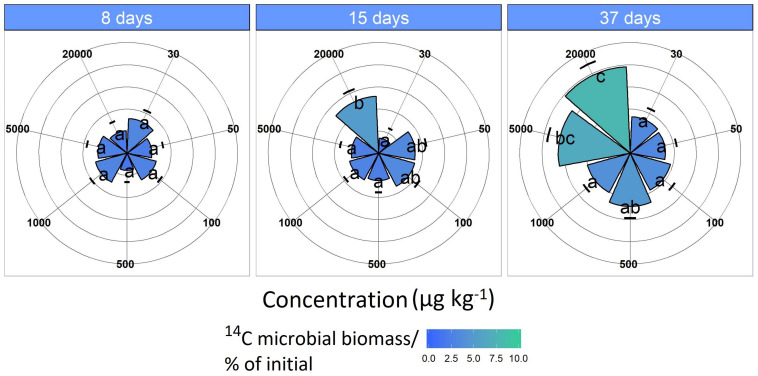
14C assimilation originates from the labeled MCPA as a function of time. Pie slices and the color gradient from blue to green represent the 14C assimilation for each concentration. Blue indicates a minor and green a higher 14C uptake. Data are presented as means ± SD. Letters indicate a statistically significant difference at p ≤ 0.05 (n = 3).